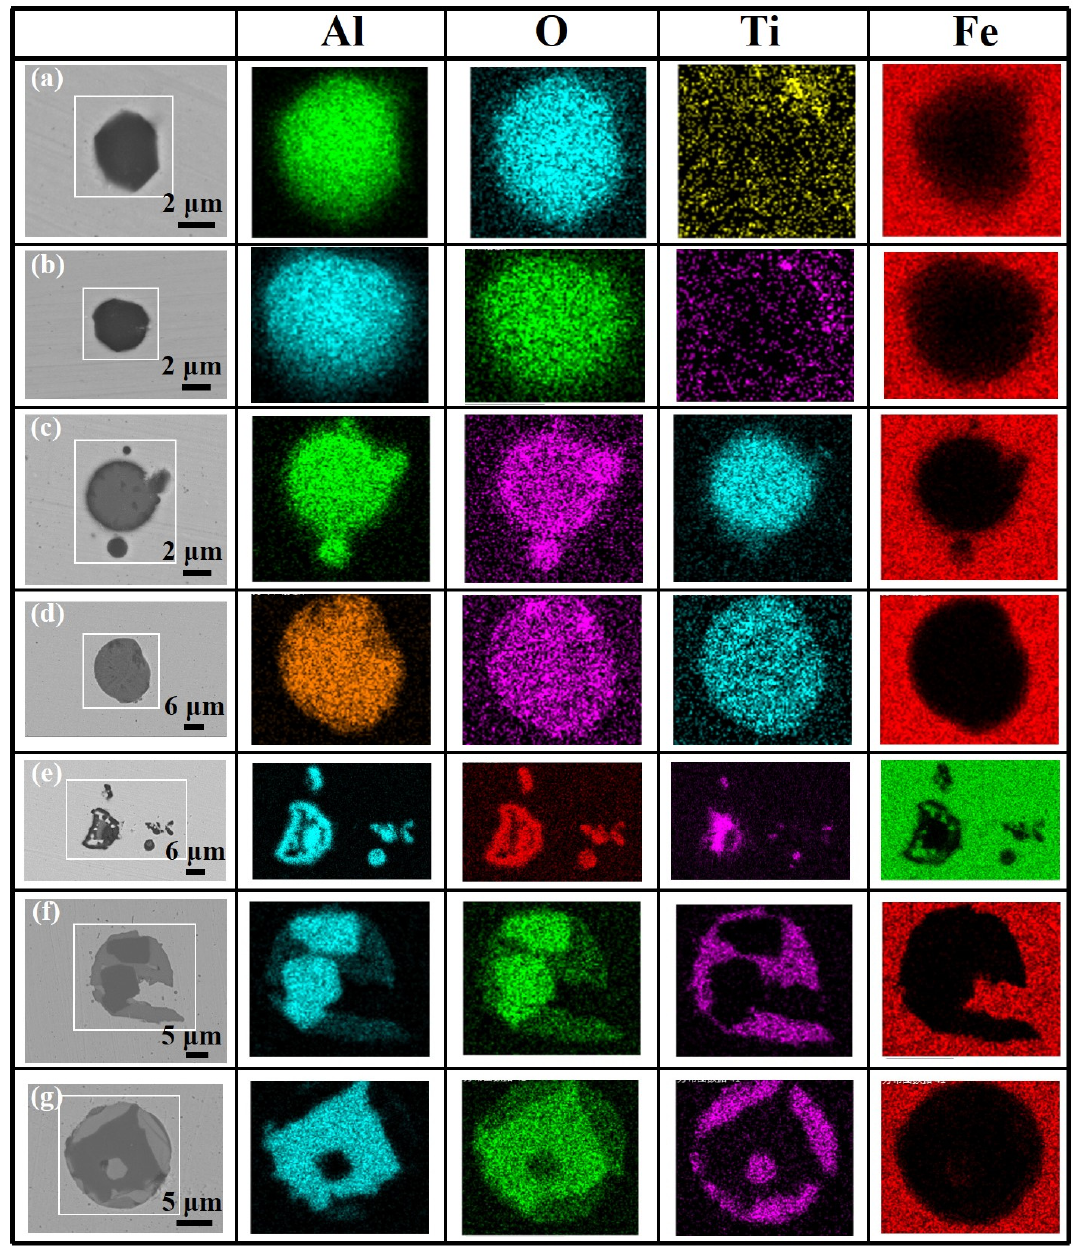
Figure 9. Elemental mapping of Al 2 O 3 · TiO x inclusions during RH treatment and tundish pro- cesses. ( a , b ) elemental mapping of Type 1 inclusions, ( c – e ) elemental mapping of Type 2 inclusions, ( f , g ) elemental mapping of Type 3